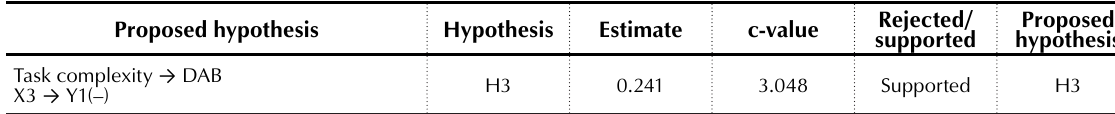
Table 3. Path coefficient of task complexity and